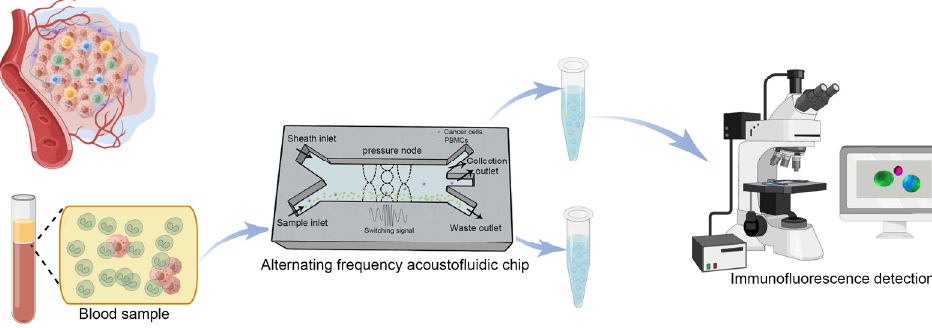
Figure 7. Schematic diagram of the separation process by acoustofluidic chip.